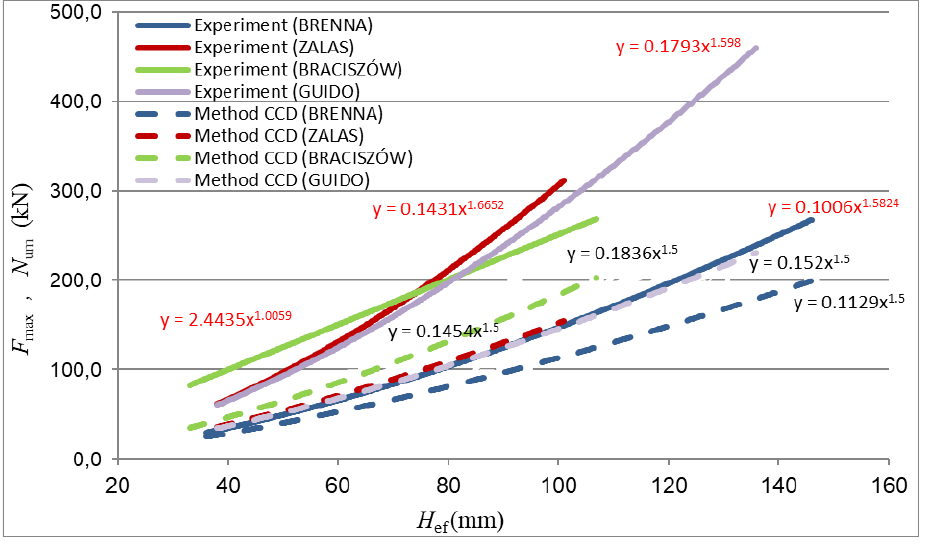
determined experimentally (Figure 13) with the anchoring load capacity max